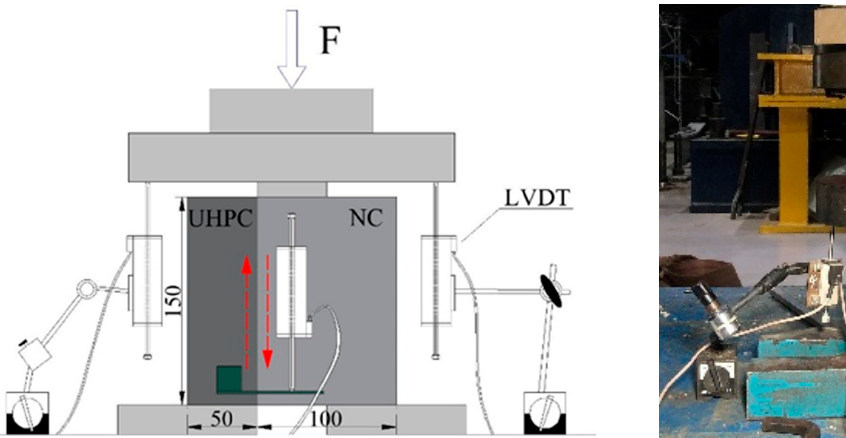
Figure 4. Layout of the bi-shear test (unit: mm).